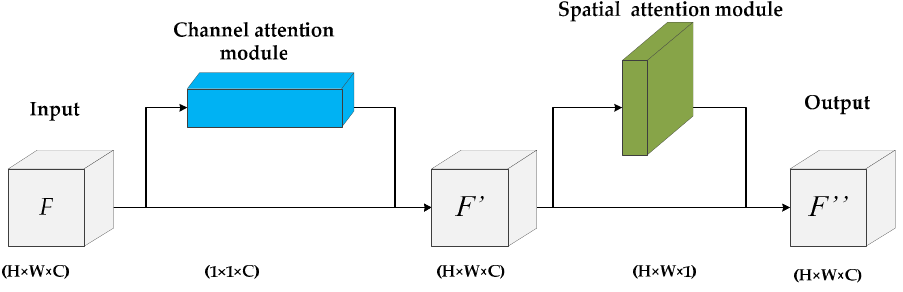
Figure 3. Diagram of the attention module.